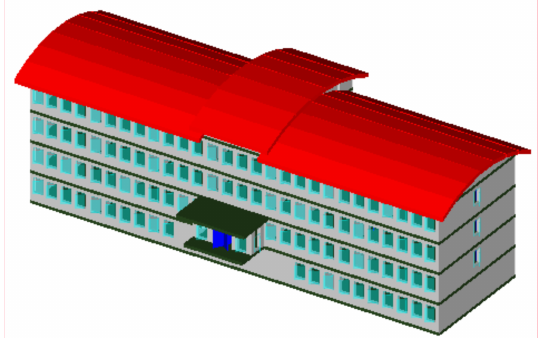
Figure 16. The Building Information Modeling (BIM) model of an o ffi ce